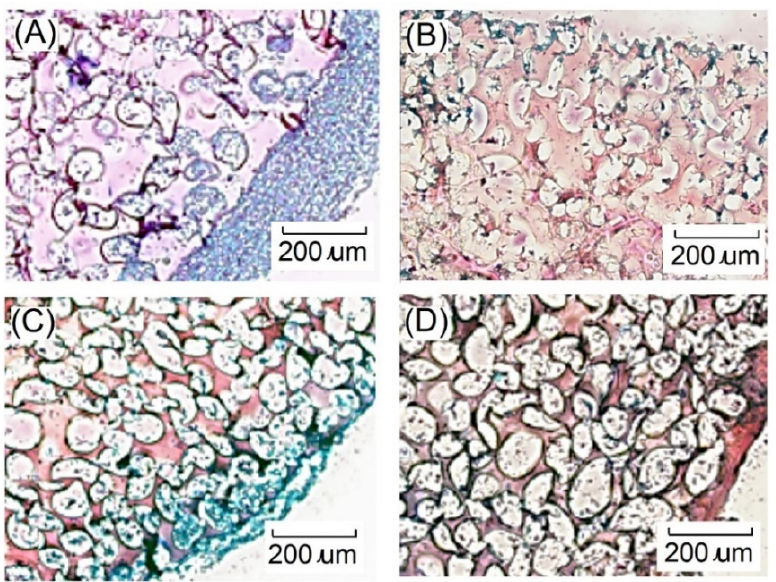
Figure 15. Images of alcian blue staining showing growth of chondrocytes on gelatin-based hydrogel scaffolds after ( A )7 days, ( B ) 14 days, ( C ) 21 days, and ( D ) 28 days of dynamic culture. Blue- glycosaminoglycan, red-nucleus, dark red-hydrogel scaffold. Scale bar represents 200 μ m.